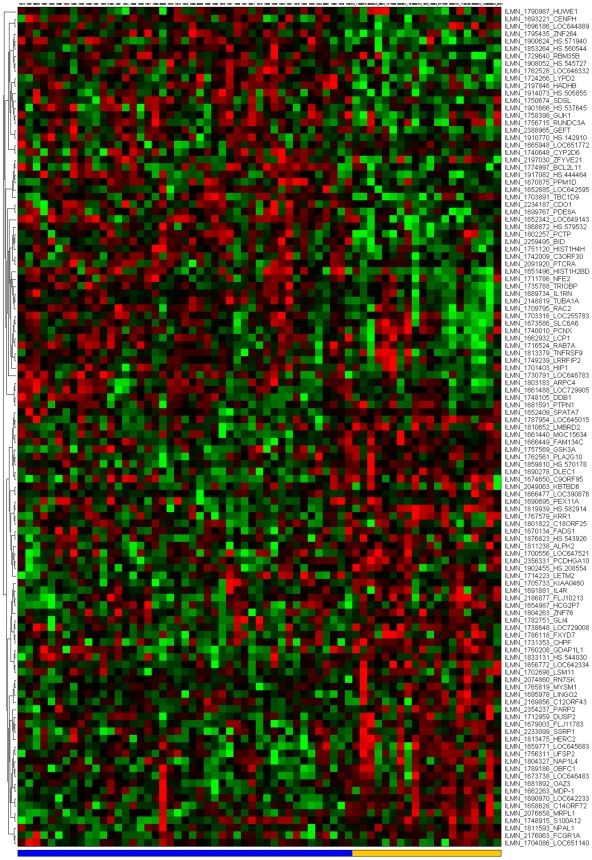
mRNA expression heatmap for the C/SP signature.Control samples (blue), SPMS (yellow).